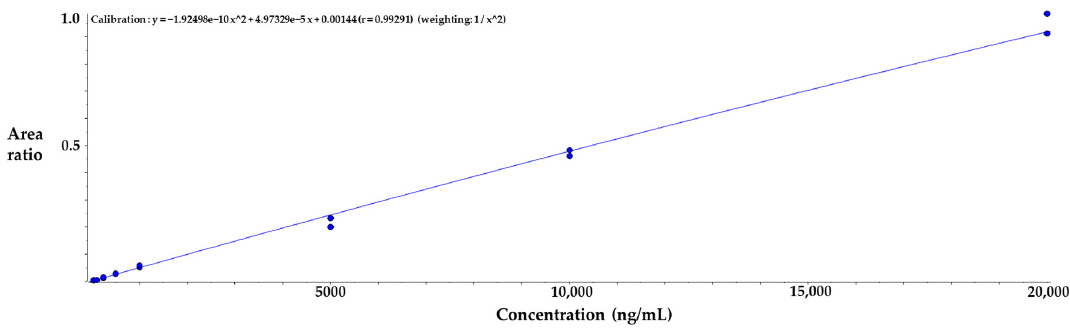
Figure 4. Representative calibration curve of SN-38 released from MAC glucuronide phenol linked SN-38.